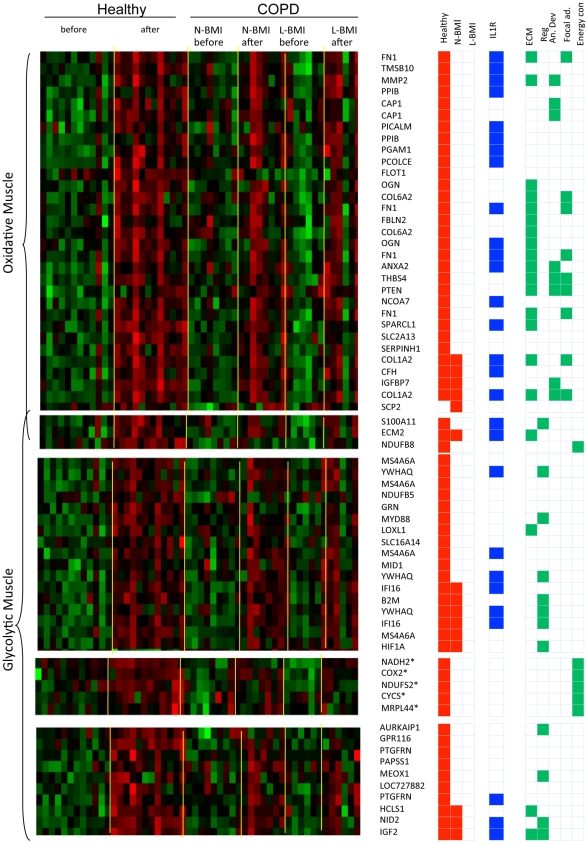
Effects of IL-1β in mouse glycolytic and oxidative muscles.This figure describes the effects of recombinant interleukin 1 on the transcriptional state of glycolytic and oxidative muscles. Panel A represents the heatmap of expression profiles in human muscle biopsies of genes that are differentially regulated in response to training in humans and also induced by IL1β in mouse muscles. Panel B shows the localisation of genes up-regulated in oxidative and glycolytic muscles on the COPD interaction network represented in Figure 1.